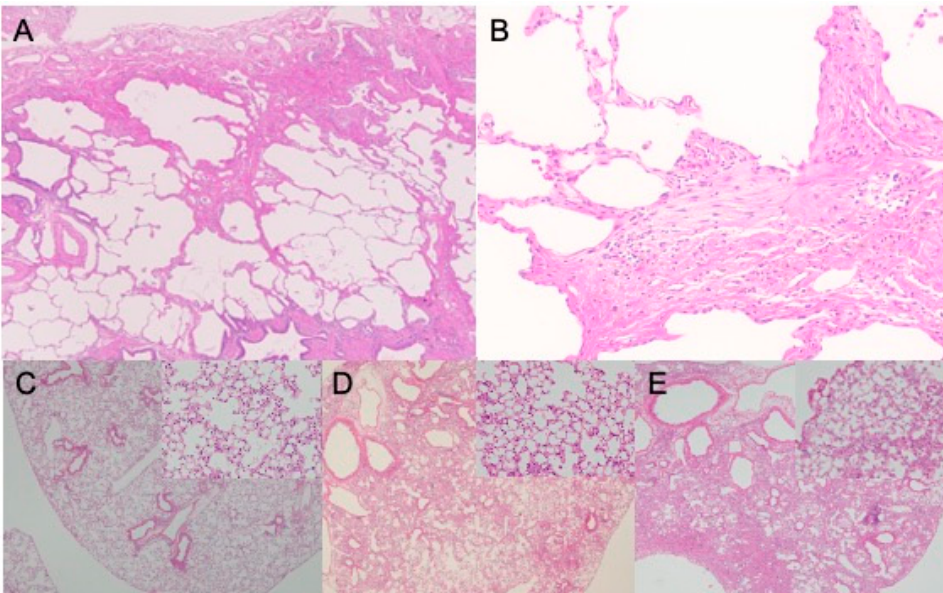
Figure 1. Representative optical microscopy images of fibrotic lungs. Hematoxylin-eosin stain for human idiopathic pulmonary fibrosis ( A , B ) and bleomycin-treated mouse lungs at day 7 ( C ), day 21 ( D ), and day 28 ( E ). The images of human idiopathic pulmonary fibrosis show usual interstitial pneumonia pattern, architectural destruction, heterogeneous patchy distribution of fibrosis with scarring and honeycomb changes, and scattered fibroblastic foci.